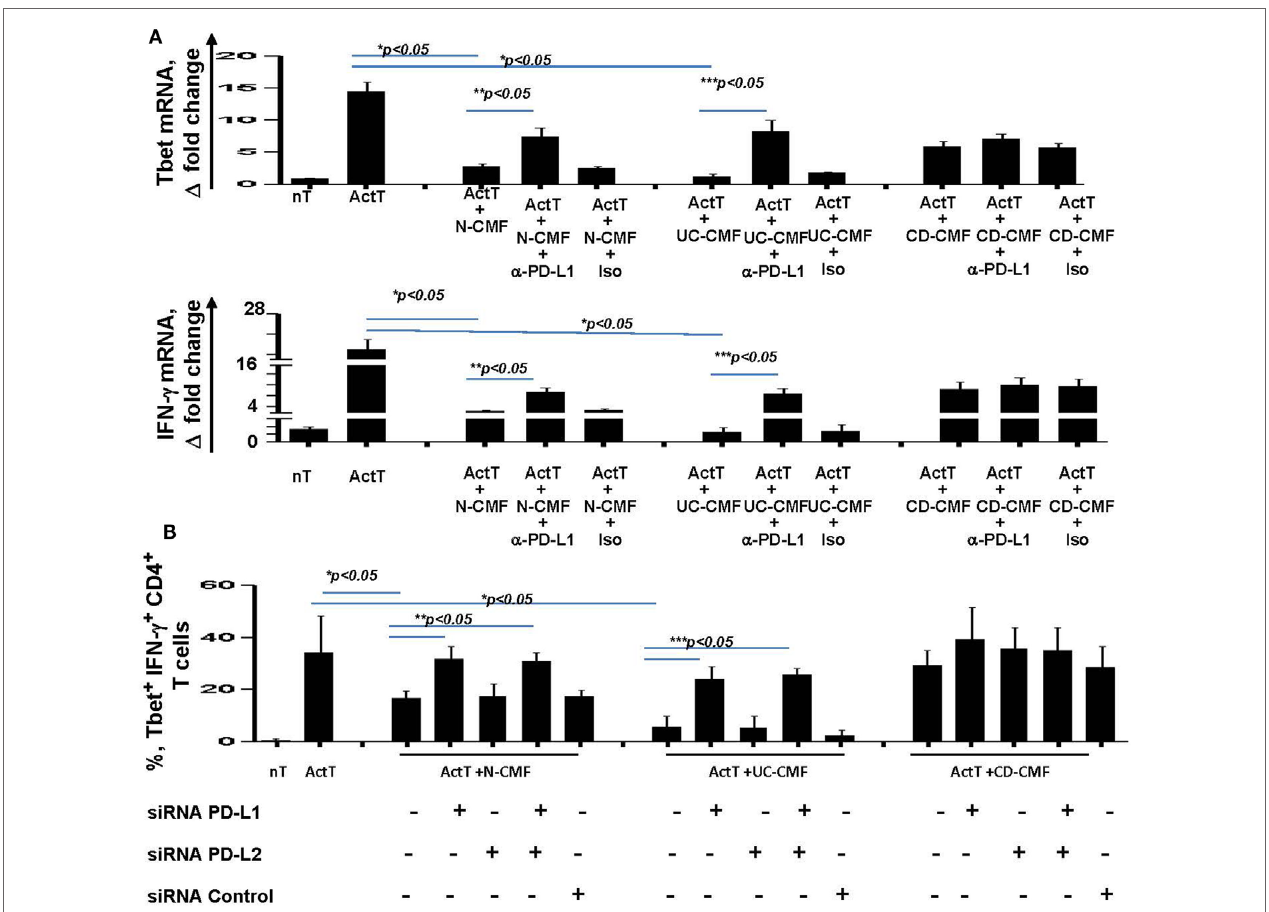
FigUre 7 | CMF-mediated suppression of Th1 type responses depend on the level of expression of the programmed death-ligand 1 (PD-L1), but not PD-L2. (a) N-, UC-, and CD-CMFs were cocultured with allogeneic CD3/CD28-activated naive CD4 + T cells in presence/absence of PD-L1 blocking monoclonal antibodies (clone MIHI) or isotype control. Tbet and IFN- γ mRNA expression by the T cells was analyzed using real-time RT-PCR analysis. The means ± SEM are shown, n = 4 allogeneic donor pairs per group, two experimental replicates each. (B) N-, UC-, and CD-CMFs transfected or not with small interfering RNA (siRNA) specific to PD-L1, PD-L2, or siRNA control were cocultured with allogeneic CD3/CD28-preactivated naive CD4 + T cells. The percentage of the T cells expressing Tbet and IFN- γ was analyzed using intracellular immunostaining followed by flow cytometry. The means ± SD are shown, n = 4 allogeneic donor pairs per group, two experimental replicates